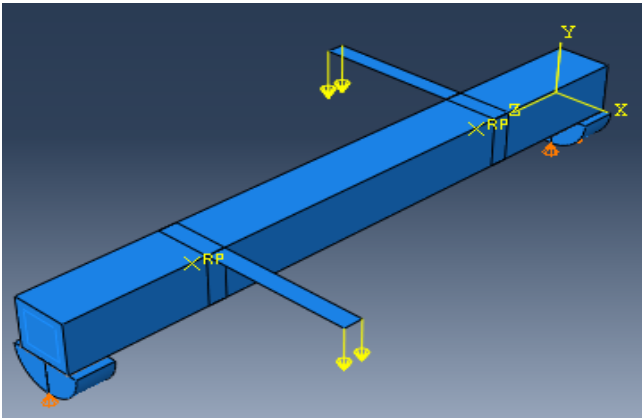
Figure 1. Rectangular beams modeled in ABAQUS.